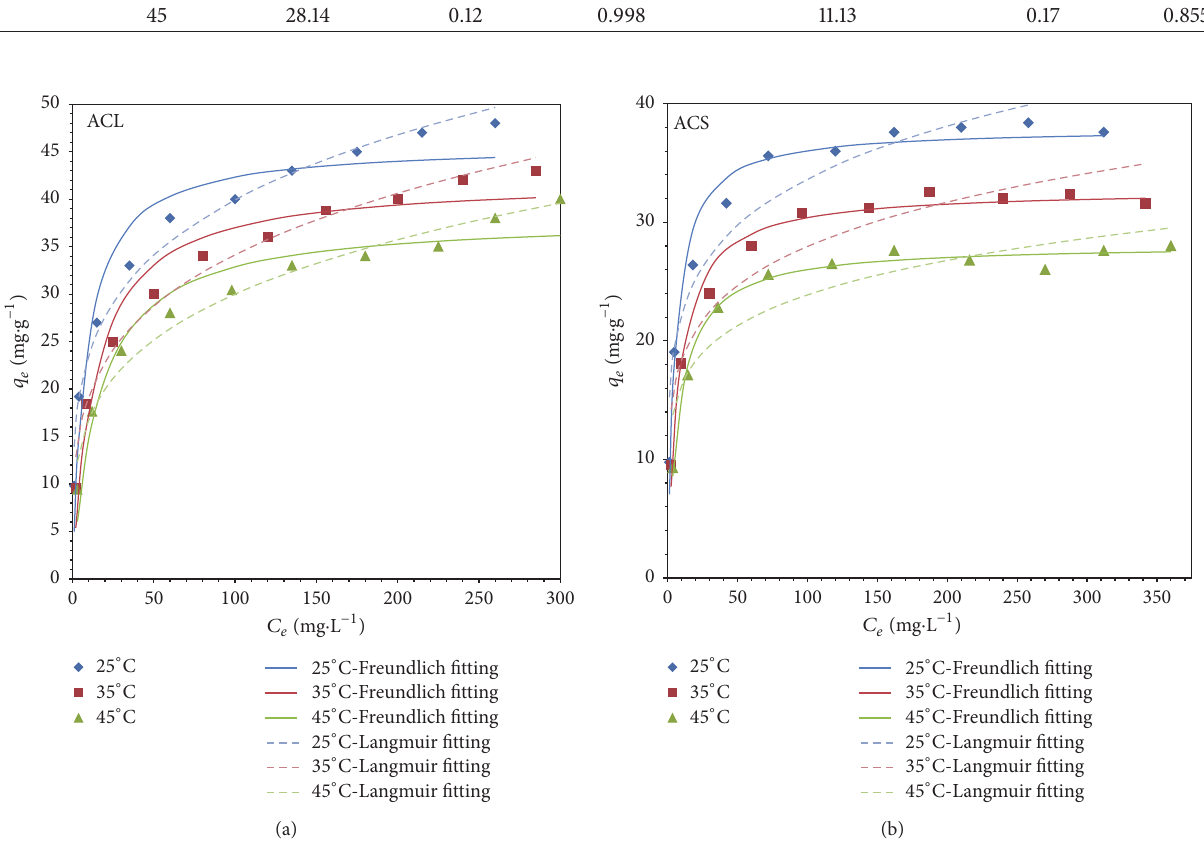
Figure 7: Adsorption isotherm of Pb(II) ions on ACL and ACS at different temperatures and fitting of adsorption data on Langmuir and Freundlich